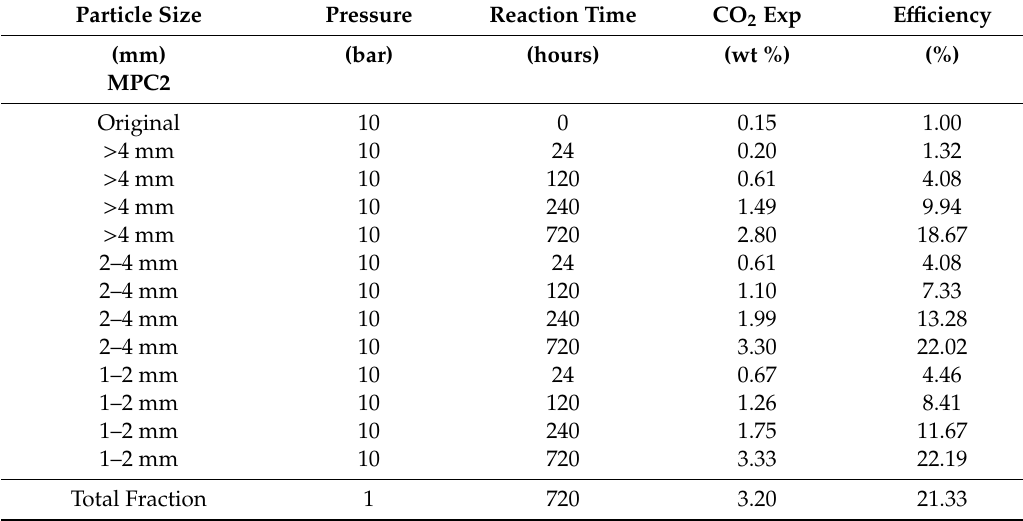
Table 4. Carbonation e ffi ciency (CE) according to Steinour’s